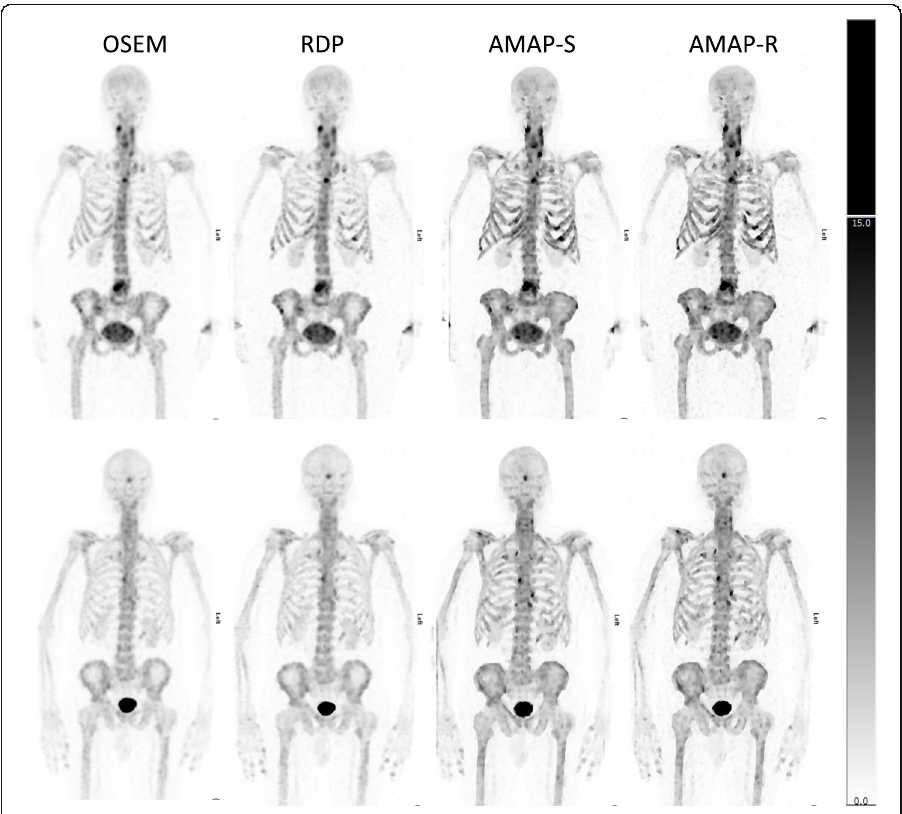
Fig. 6 Anterior MIP of two clinical patient studies (first study in top row and second in the bottom). The color scale is set to SUV 15 for all